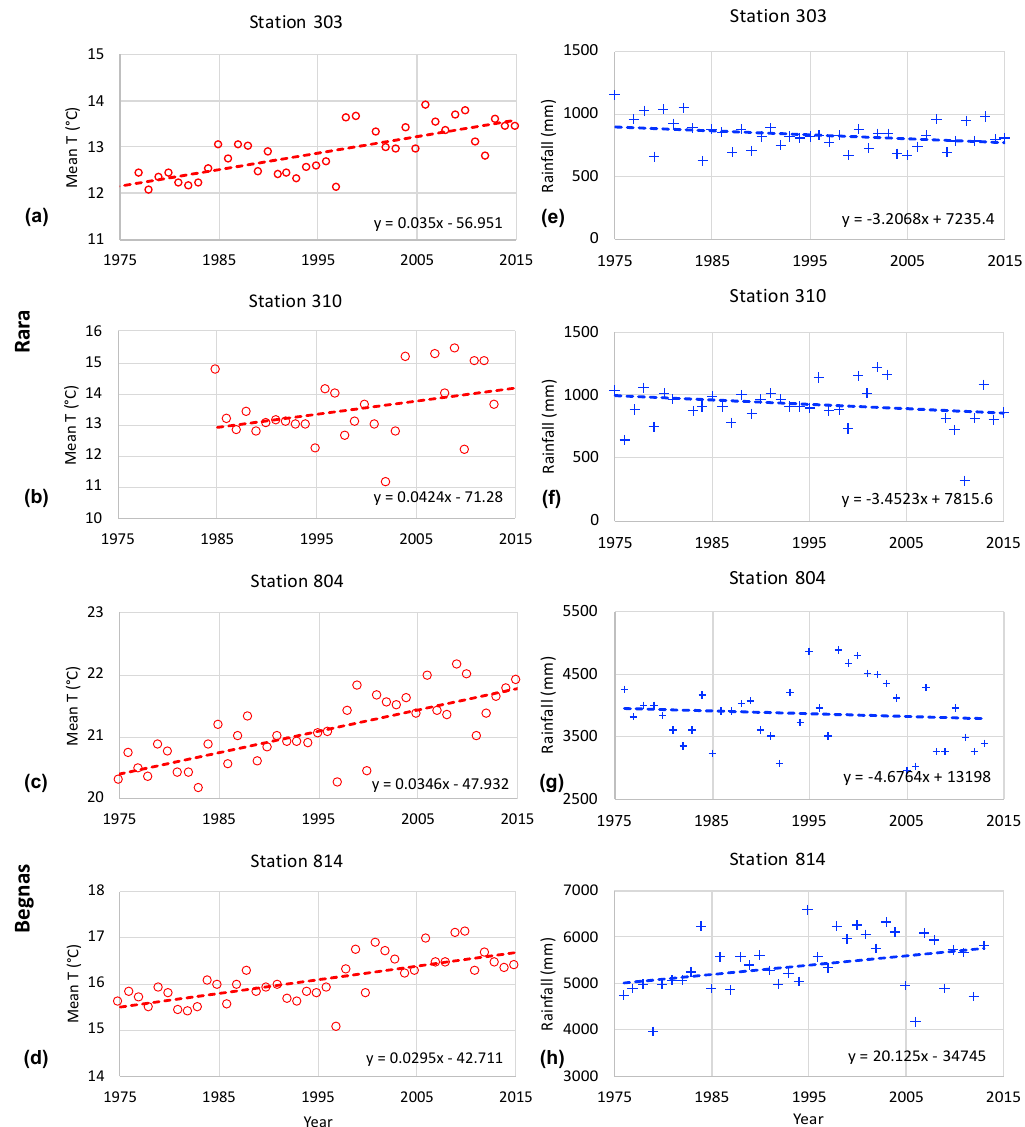
Figure 9. Annual mean temperature ( a – d ) and total precipitation ( e – h ) trends in the Rara ( a , b , e , f ) and Begnas ( c , d , g , h ) Lakes, according to the ground station data.